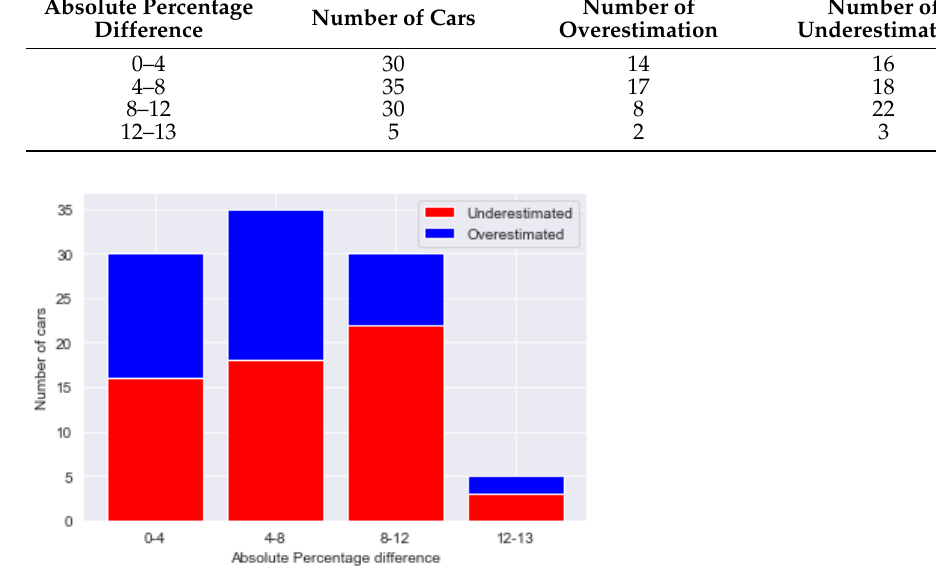
Figure 21. Number of overestimated and underestimated